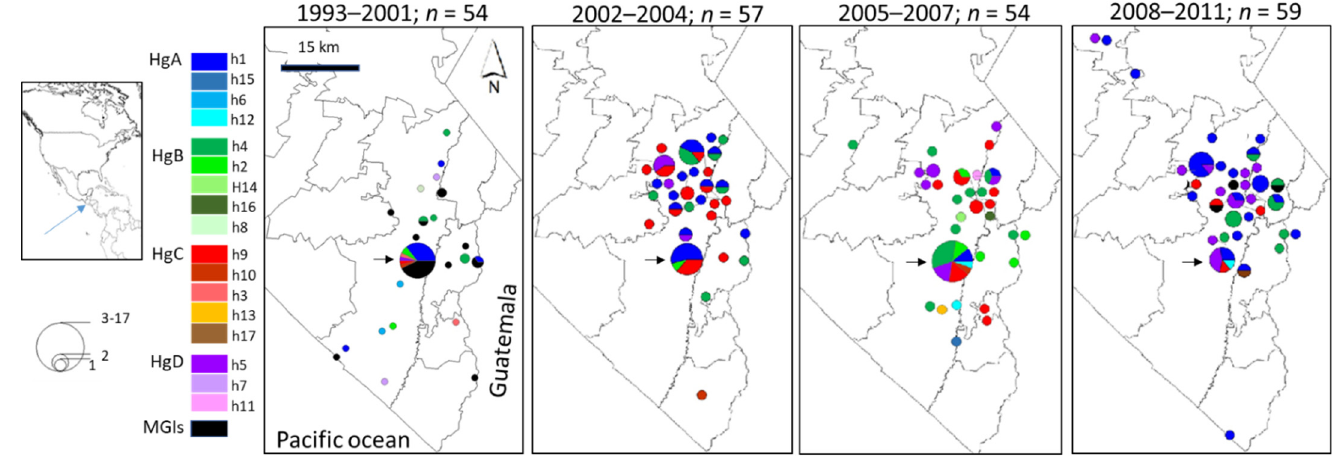
Figure 3. Geographic distribution of pvmsp1 42 haplotypes during four time periods from 1993–2011. The size of the circles is proportional to the number of isolates from each rural area and Tapachula City. Haplogroups are illustrated in the same colors and haplotypes in the same shades as in Figure 2. The spatial pattern of haplogroups varied from one period to another. The multiple genotype infections (MGIs) detected in 1993 – 2001 displayed a scattered distributed in the region. The largest circle on each map corresponds to Tapachula City (short arrow). A significant difference in the proportion of haplotypes existed when comparing samples from 2002 to 2004 and 2005 to 2007 [ 𝜒 2 (11) = 27.2781; p = 0.004], 2005 to 2007 and 200 to 2011 [ 𝜒 2 (12) = 38.4027; p = 0.000], and 2002 to 2004 and 2008 to 2011 [ 𝜒 2 (7) = 18.5703; p = 0.010].